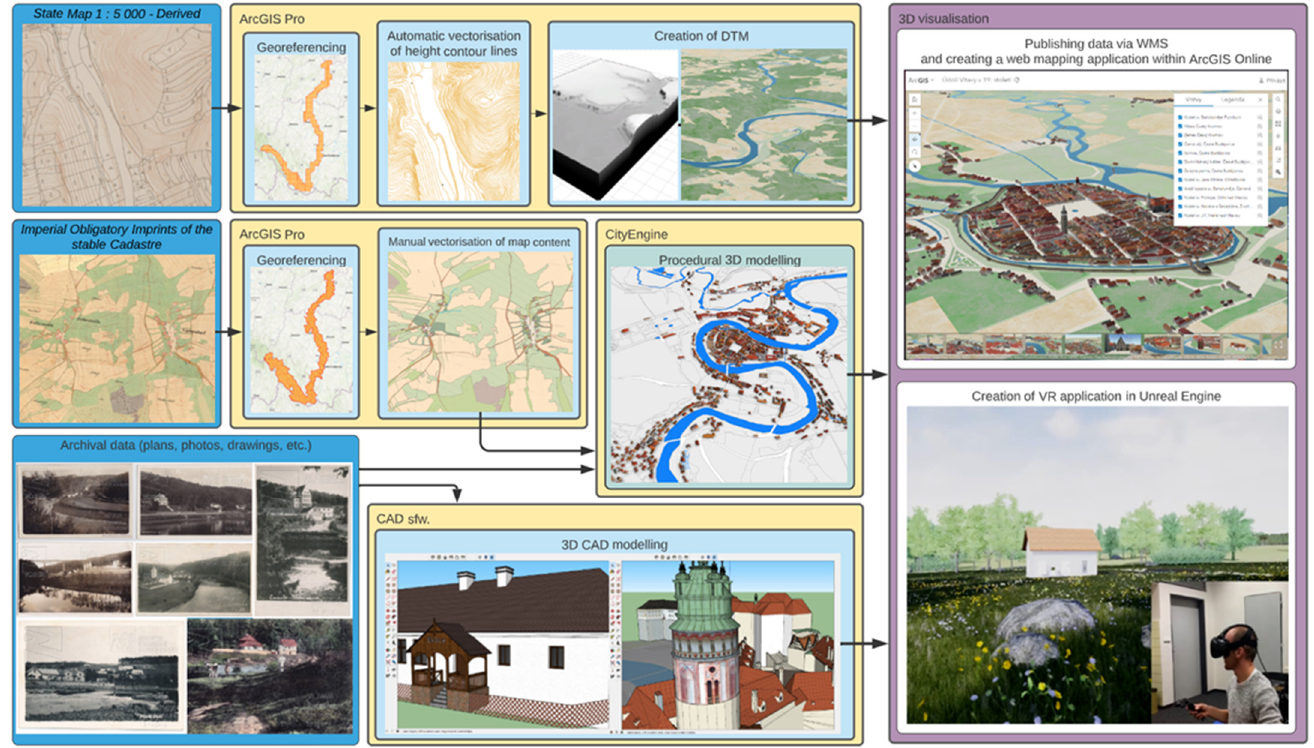
Figure 1. Flowchart showing the processing procedure with image examples.